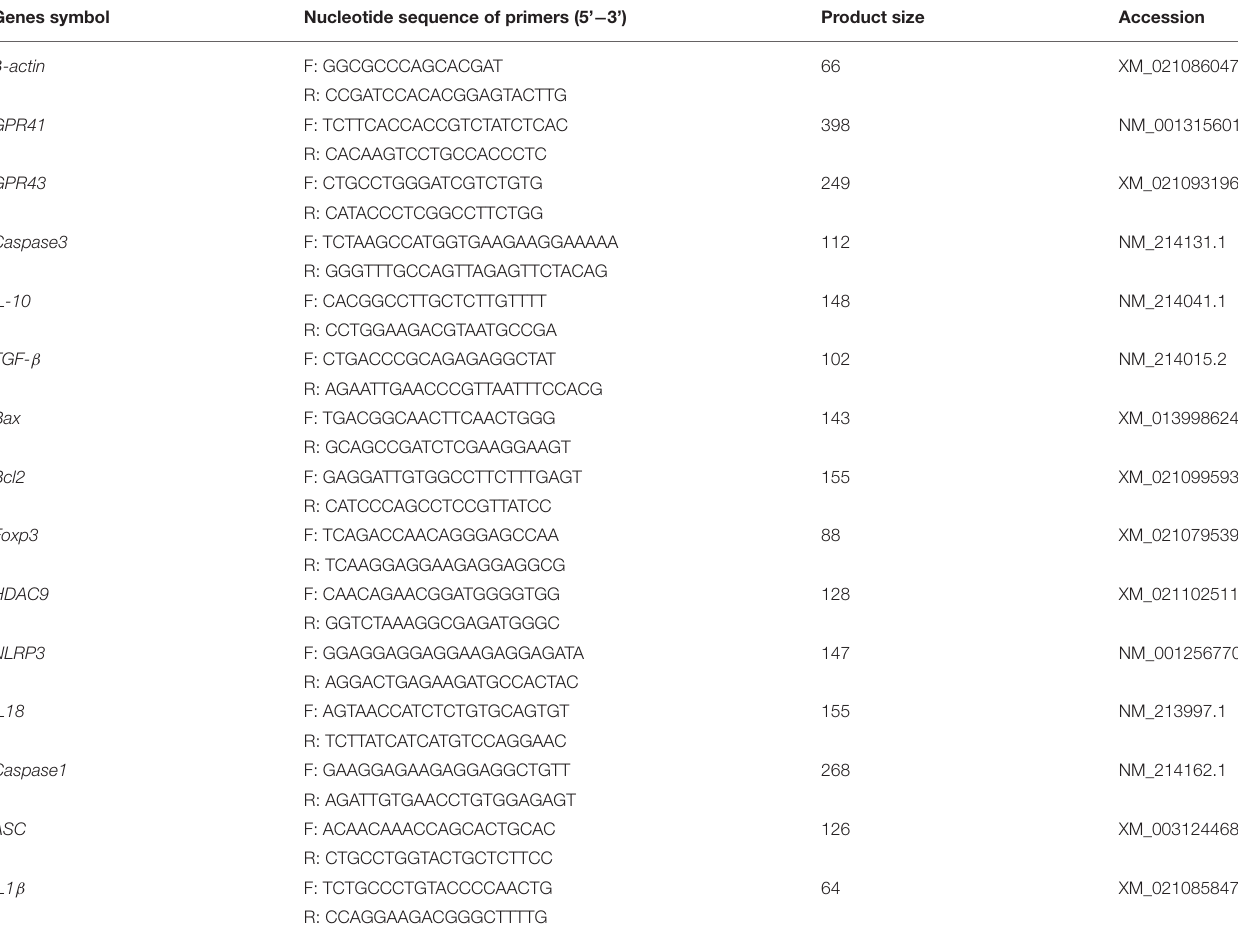
TABLE 2 | Primer sequences of the target and reference genes a,b . Genes